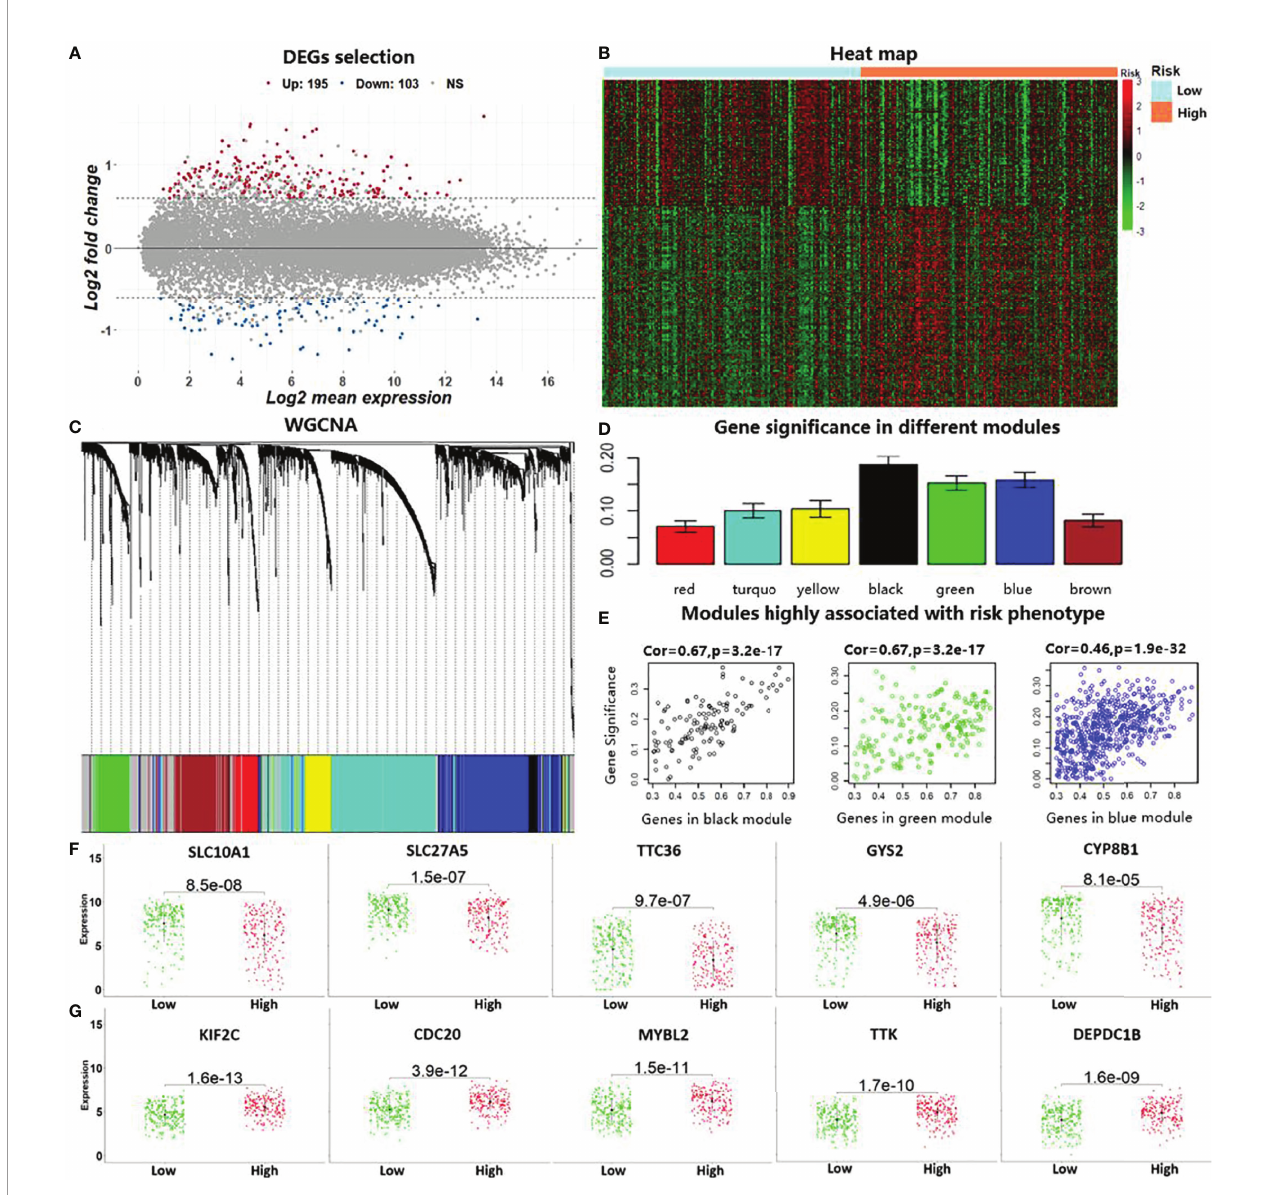
FIGURE 4 | Identi fi cation of prognostic markers by conducting differential expression analysis and weighted gene co-expression network analysis (WGCNA). (A) The 298 identi fi ed differentially expressed genes (DEGs) with |log2 fold change| >0.7 and corrected p -values <0.05 in the liver cancer data (LIHC) in TCGA. (B) . Heat map using the DEGs with predicted risk subgroups in LIHC. (C) . WGCNA for calculating co-expression modules. (D) . Computed average gene signi fi cance values in the different modules. (E) Three identi fi ed modules that are associated with risk phenotypes in hepatocellular carcinoma (HCC). (F) Differences in the identi fi ed downregulated risk genes in the HCC risk subgroups by gene expression level. (G) Differences in the identi fi ed upregulated risk genes in the HCC risk